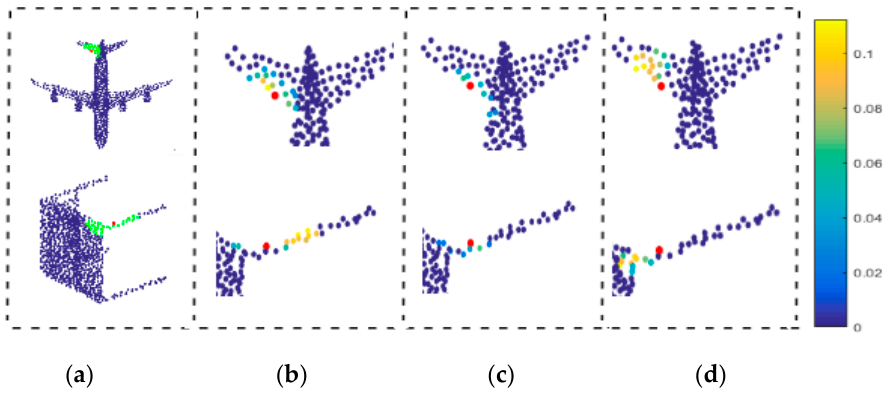
Figure 6. The contribution degree output from the three heads when the center point is an edge point. ( a ) Two point cloud models. ( b ) The first head. ( c ) The second head. ( d ) The third head. In Figure 6, as shown in the right colored bar, the closer the color of a neighborhood point is to yellow, the more features the network learns from the neighborhood point when processing the local region of the red point. Figure 6a shows the input models in which the green points indicate the initial neighborhood of the red point. Figure 6b–d show the contribution of the neighborhood points learned by the three heads to the center point.